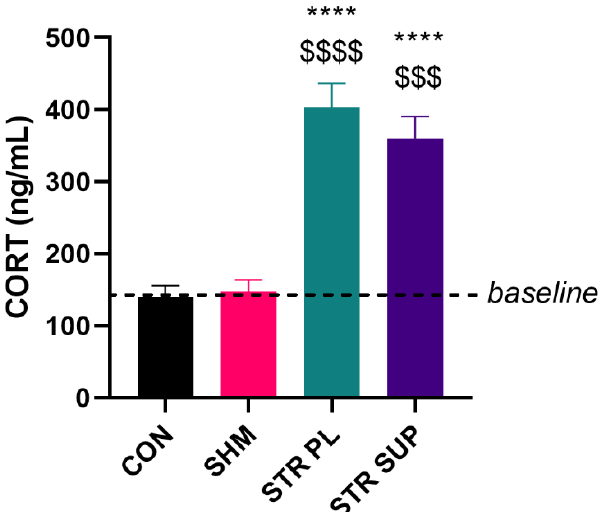
Figure 1. The level of corticosterone (CORT) in plasma. Results are expressed as mean ± SEM. CON ( n = 6), SHM ( n = 6), STR PL (=9), STR SUP ( n = 9), **** p < 0.0001 vs. CON, $$$$ p < 0.0001 vs. SHM, $$$ p < 0.001 vs. SHM. CON: control group; SHM: sham cold water immersion group; STR PL: cold water immersion group supplemented with placebo; STR SUP: cold water immersion group supplemented with vitamin D 3 .